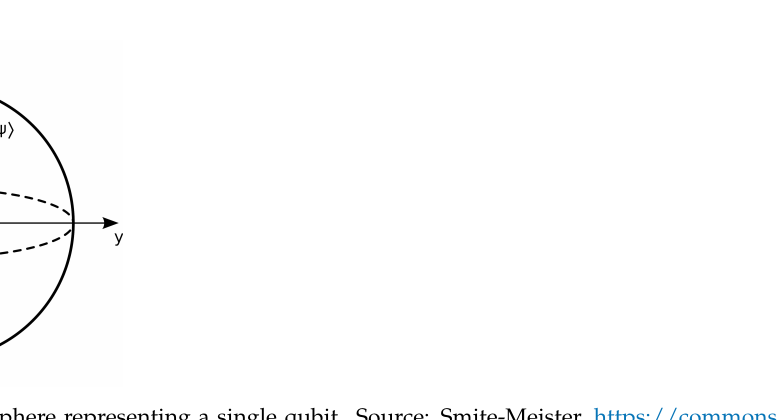
Figure 3. A Bloch sphere representing a single qubit. Source: Smite-Meister, https://commons. wikimedia.org/w/index.php?curid=5829358 (accessed on 2 January